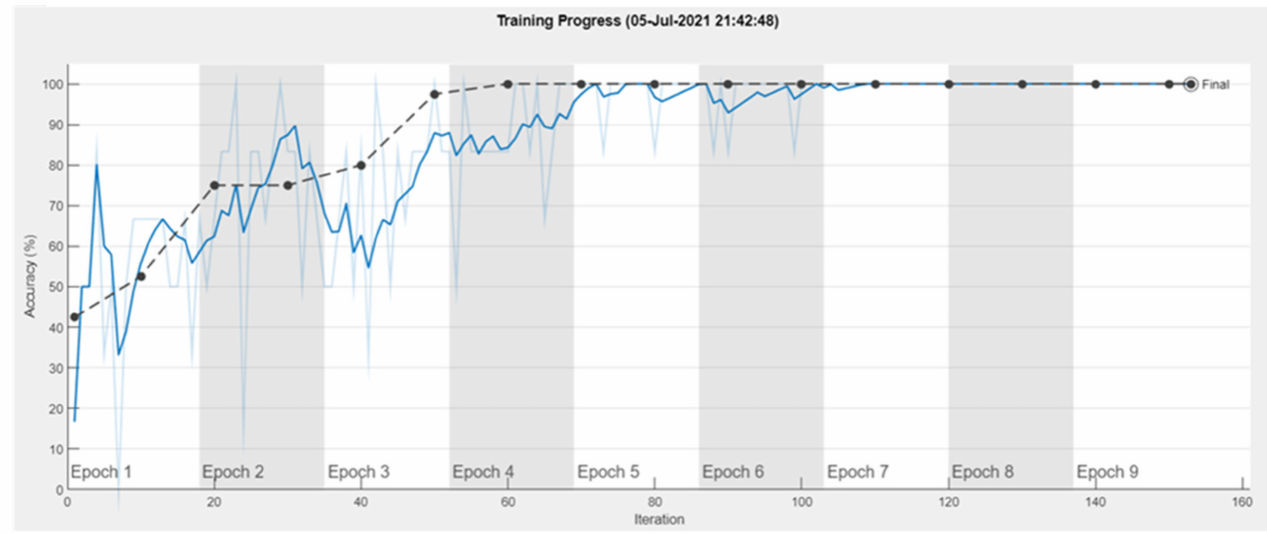
Figure 6. Training and validation accuracy progress for the radial stray flux signal: training in light blue and in blue (smoothed), validation in black dashed.